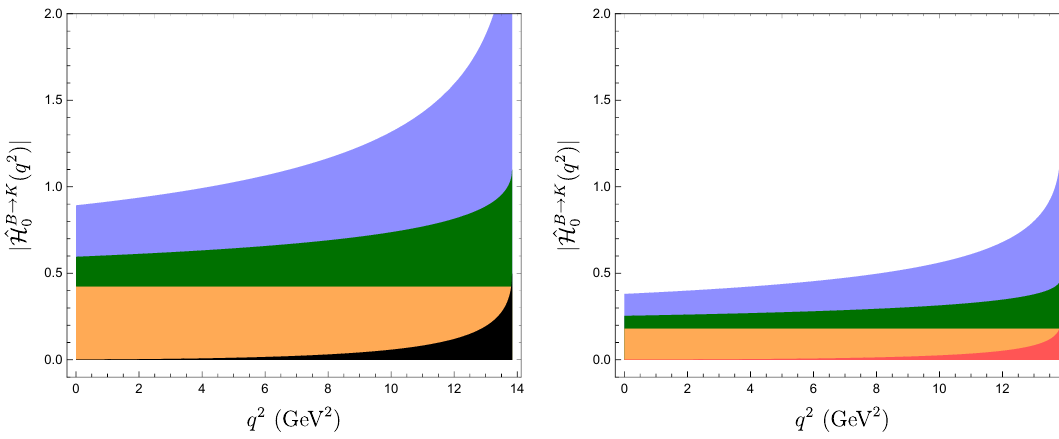
ˆ according to the dispersive bound H B → K 0 ¯ ¯ ¯ B → K ( ∗ ) ‘ + ‘ − and B s → φ‘ + ‘ − modes